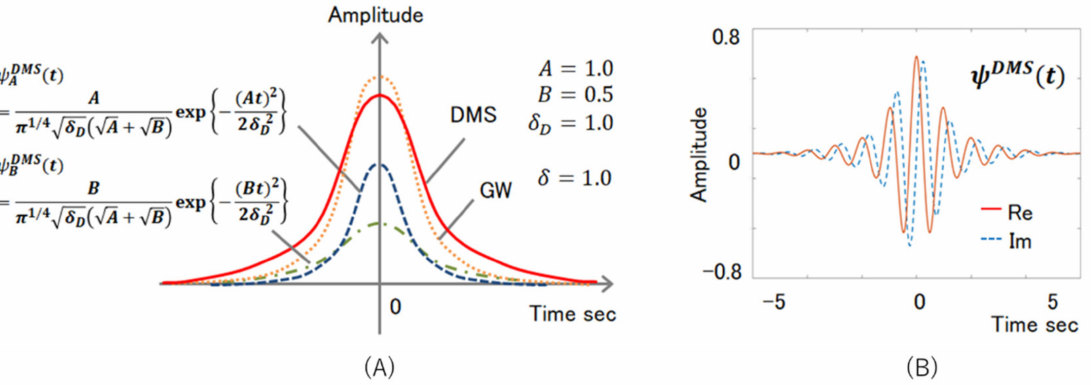
Figure 3. ( A ) is example of the DMS function outline. And ( B ) is the example of the DMS function external shape, the solid red line is a real number, and the broken blue line is an imaginary